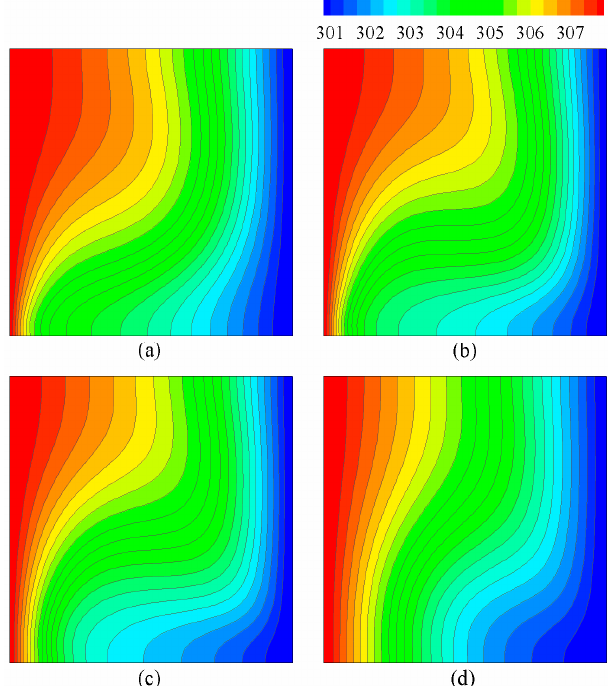
Figure 4. Temperature field for different locations of the magnet with Br = 2.0 T; ( a ) x m / L = 0.2, ( b ) x m / L = 0.4, ( c ) x m / L = 0.6, and ( d ) x m / L = 1.0. ( b ) x m / L = 0.4, ( c ) x m / L = 0.6, and ( d ) x m / L =